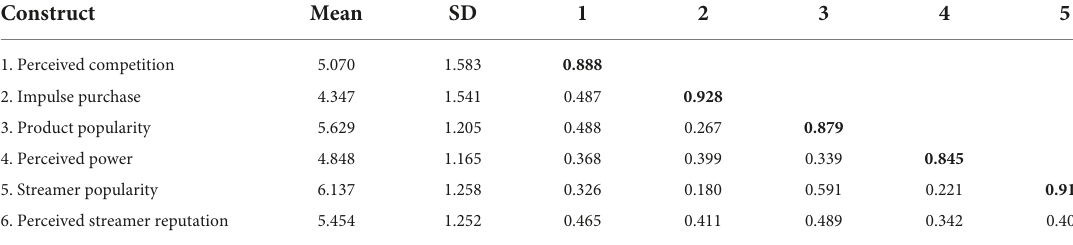
TABLE 5 Results of correlation analysis and discriminant validity tests.